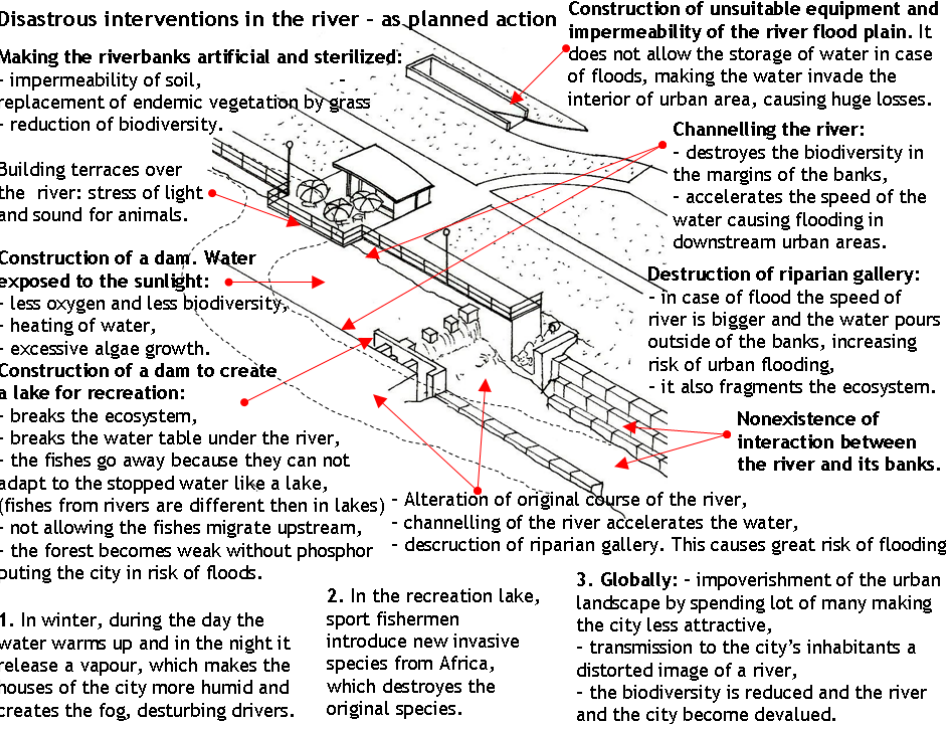
Figure 5a: Disastrous interventions in the urban river areas as a result of its artificial modernization. The planned action to regulate the water stream and to make the “brand new” environment for tourists will have dramatic results in the future. The floods in the world are proving, that such way of “interfering revitalization” is deeply changing the relations in the nature and therefore has always negative con- sequences for the human habitat.